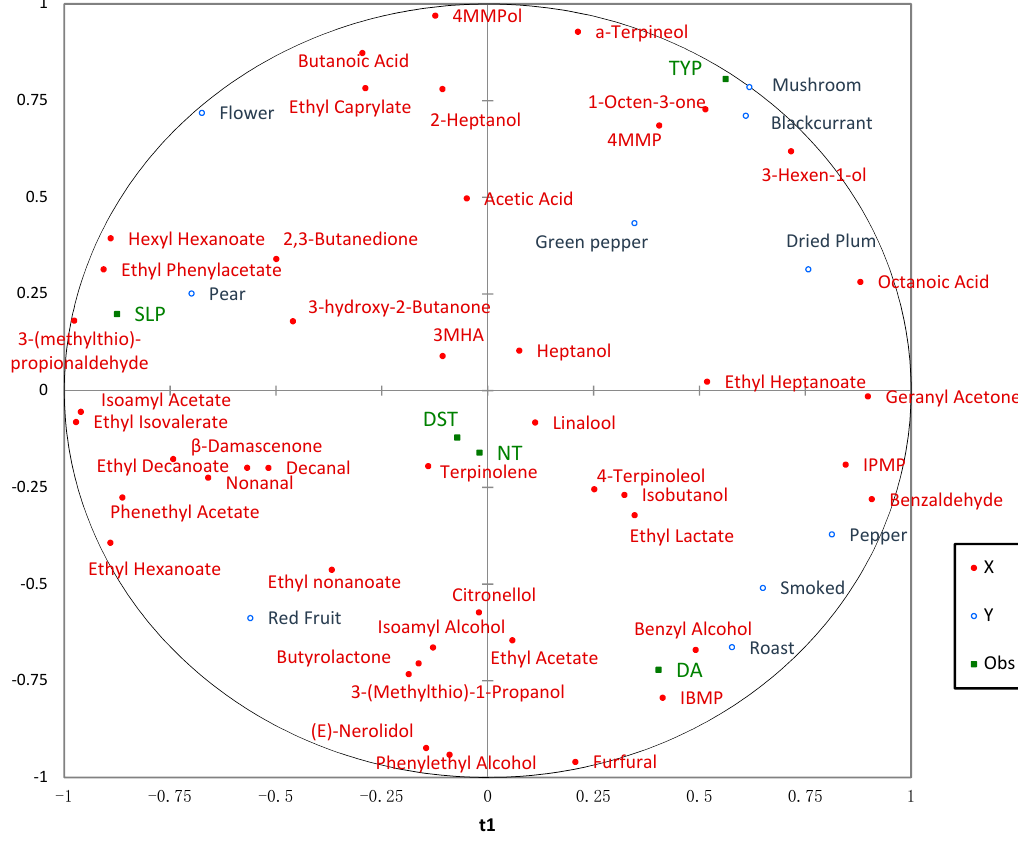
Figure 2. Partial least squares regression (PLSR) analysis, chemical, sensory data and the correlation of Cabernet Sauvignon wines from the Chinese Loess Plateau region (t1, sensory data; t2, chemical data). SLP, TYP, NT, DA and DST are the abbreviations for five young vineyards in the Loess Plateau region .